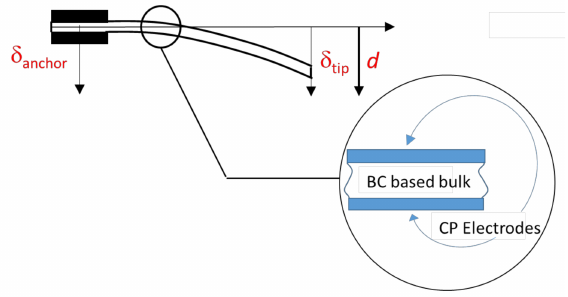
Figure 4. A scheme of the BC composite deformation d , along with the reference directions for the anchor and tip